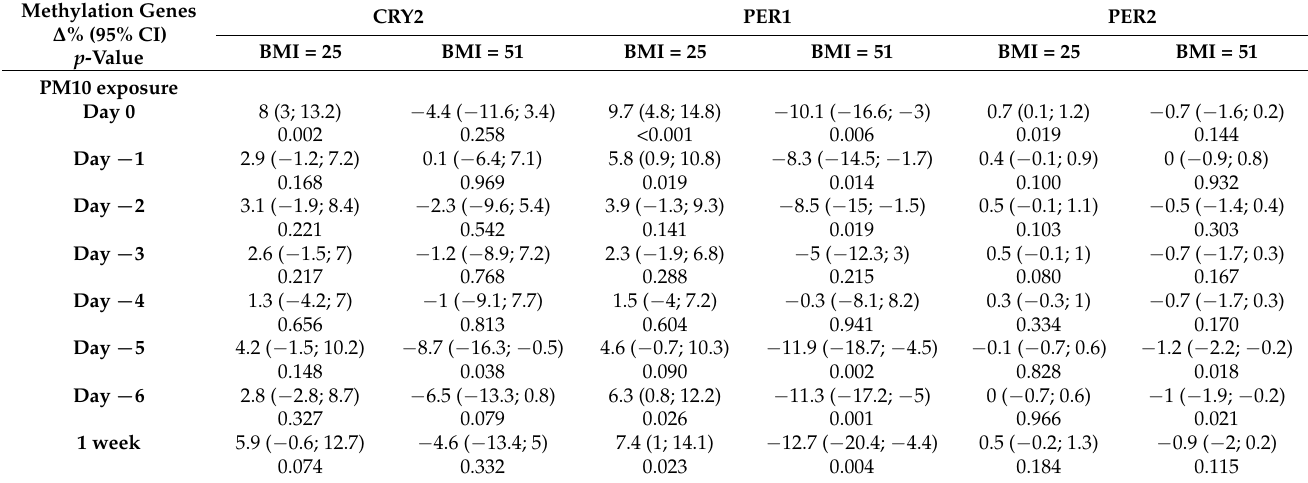
Table 6. Association between PM 2.5 exposure and the methylation of the CRY2 , PER1 , and PER2 genes for selected BMI values. Significant associations ( p -value < 0.05) are highlighted in bold characters.